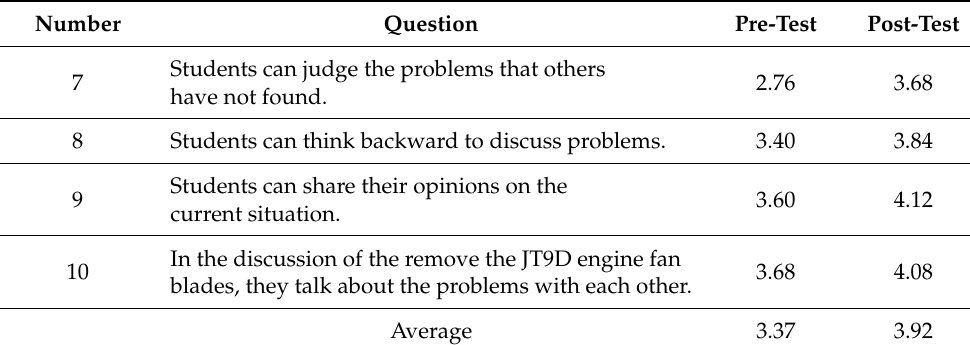
Table 5. Results for the problem commenting ability.